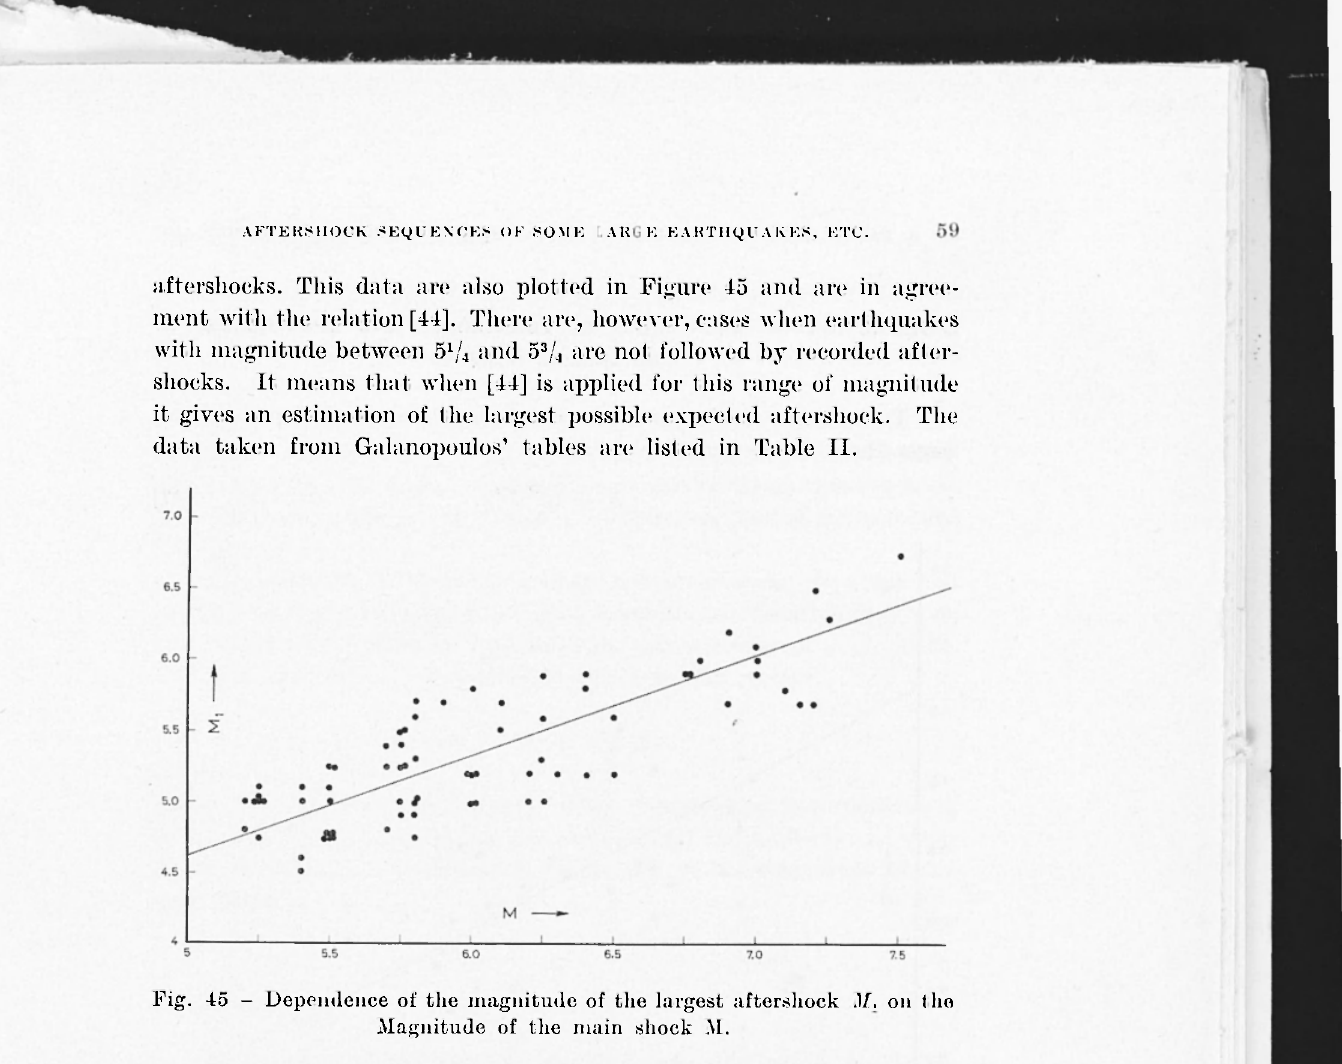
Fig. 45 - Dependence of the magnitude of the largest aftershock on t he Magnitude of the main shock